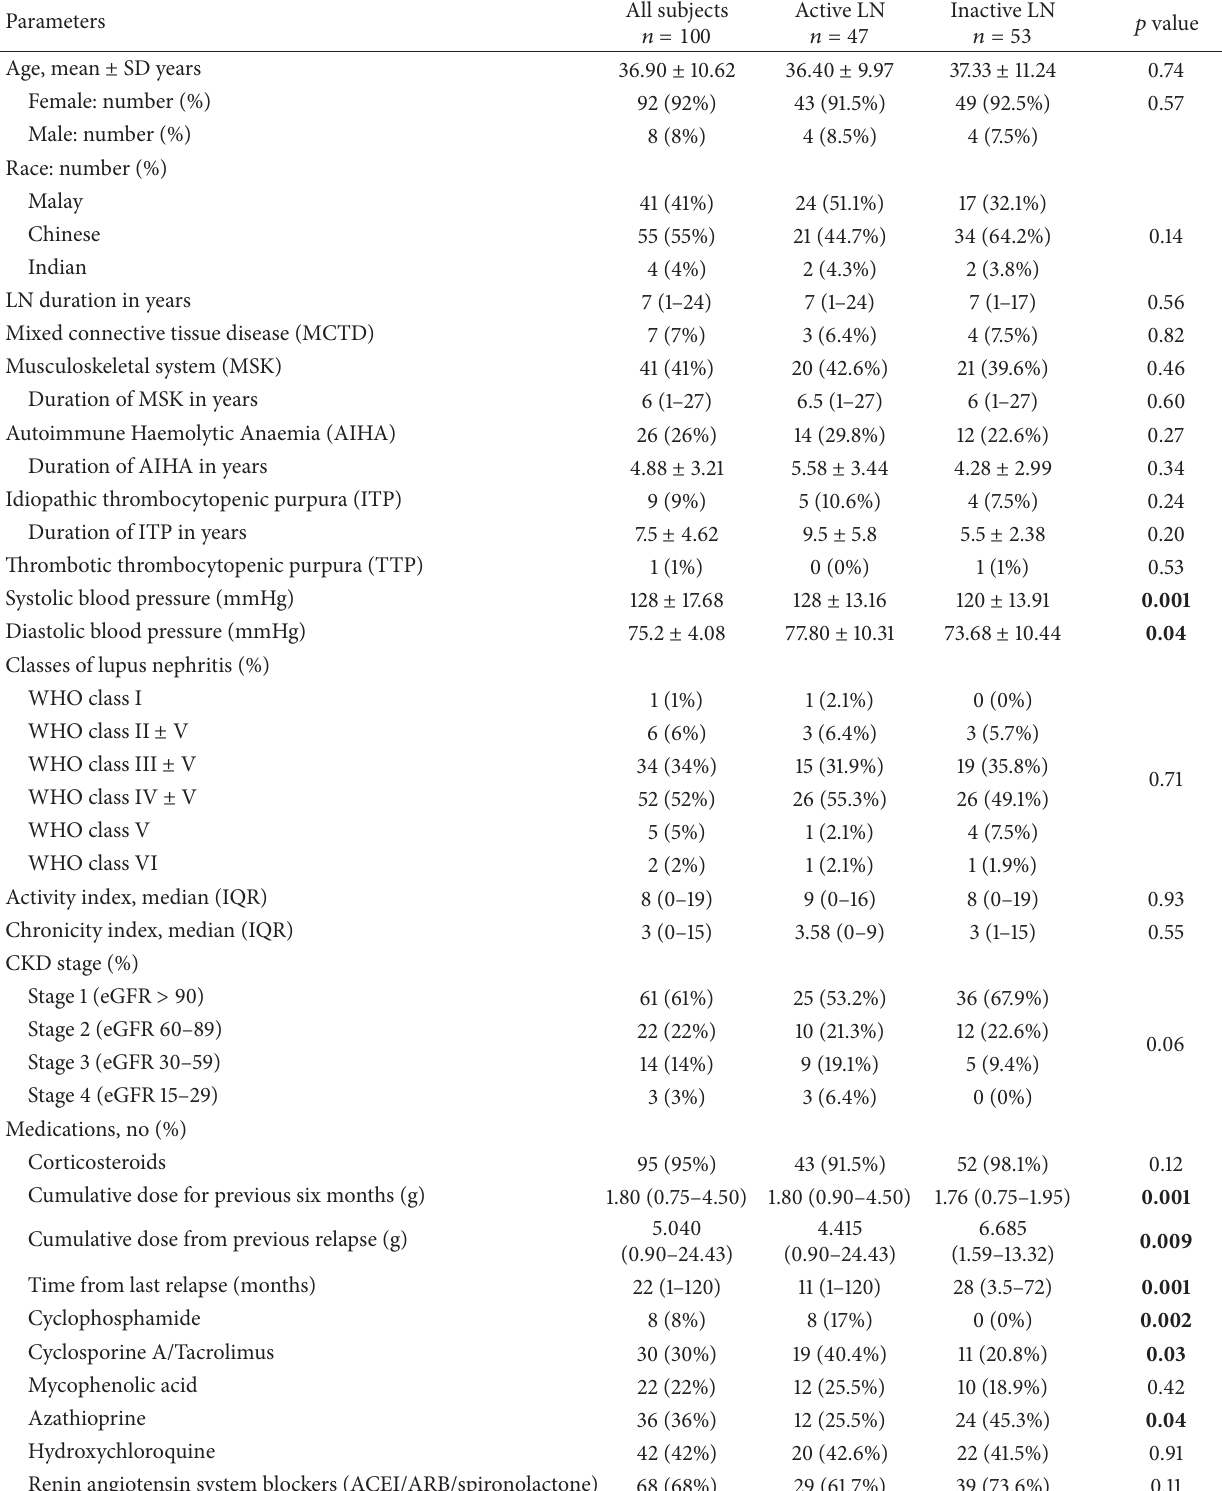
Table 2: Baseline demographic and characteristics in the active and inactive LN patient